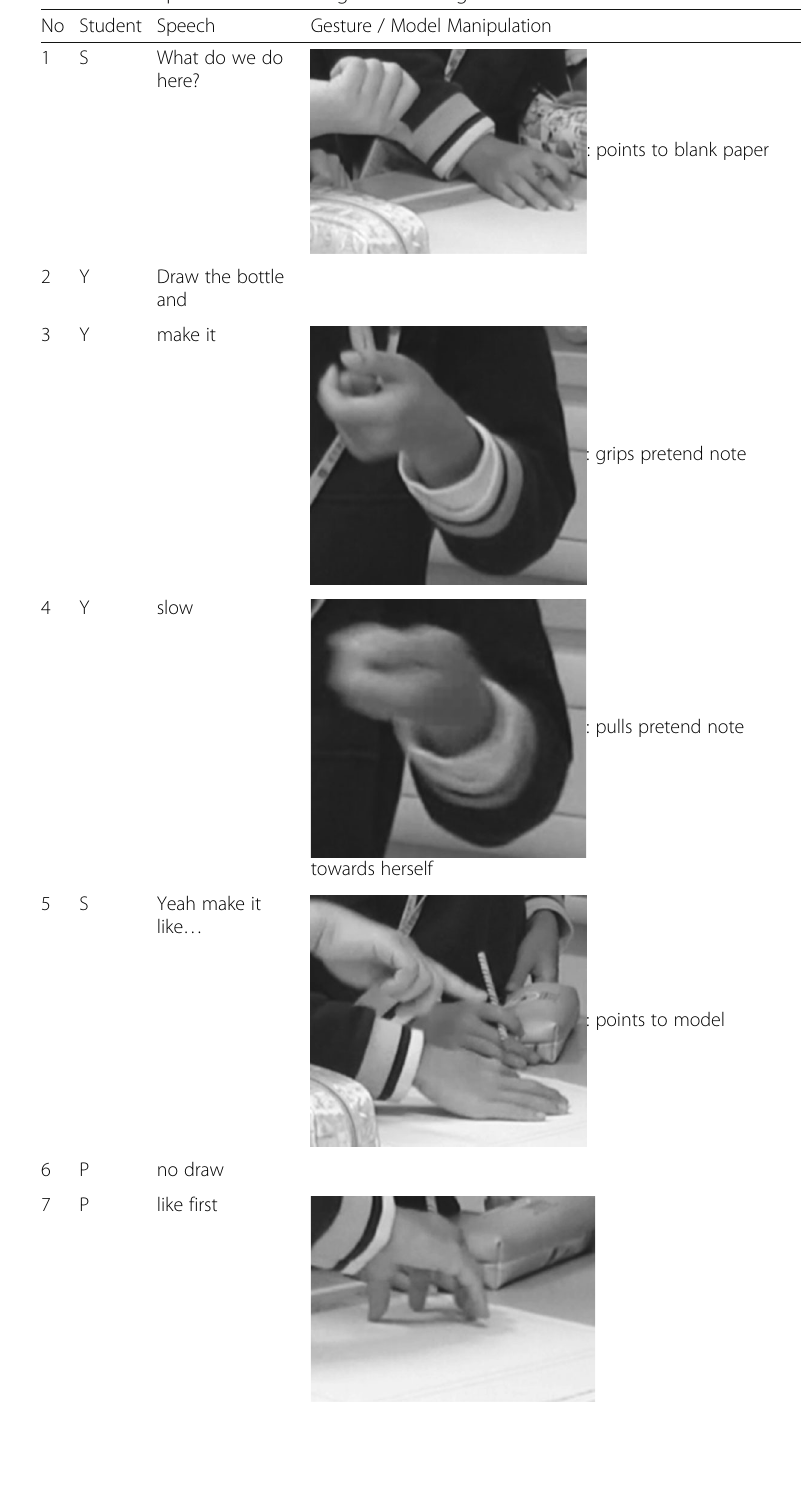
Table 4 Group 2 Co-Constructing the